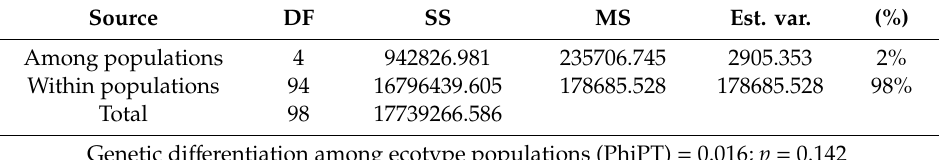
Table 2. Analysis of molecular variance (AMOVA) of Ugandan Brachiaria ecotypes.